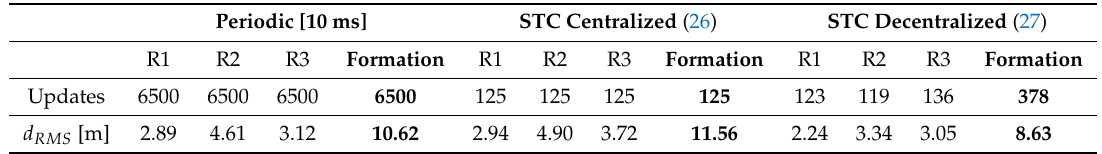
Table 3. Comparison of the update number and RMS value of distance concerning the different control strategies for trajectory tracking, including the periodic implementation, the STC with centralized triggering (26) and the STC with decentralized triggering